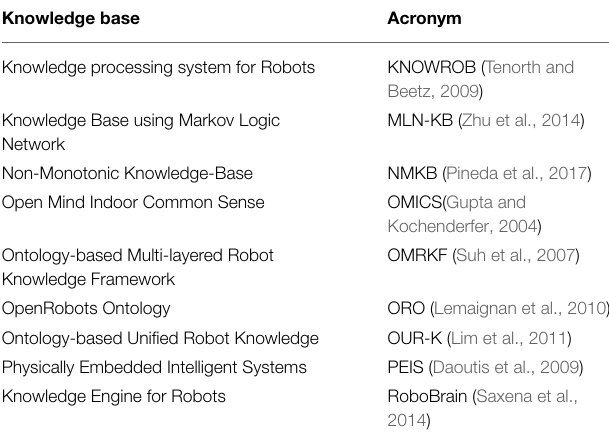
TABLE 1 | List of selected knowledge bases and their names originally appeared in Thosar et al.